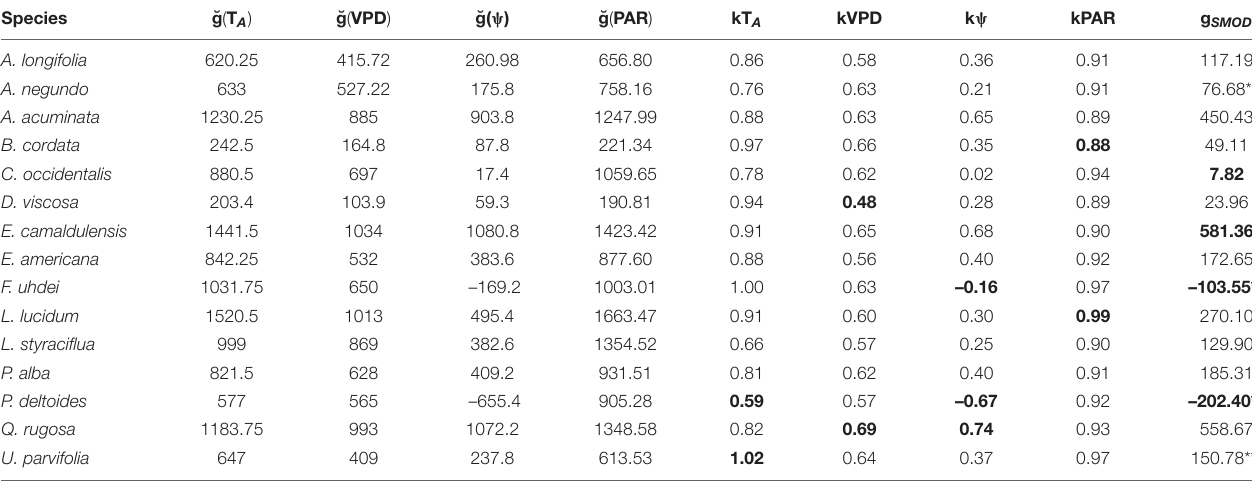
TABLE 6 | Predictions of stomatal conductance (g S ) using a multiplicative model (equation 5 from Methods, g SMOD ) and the contribution of each environmental ( kT A , kVPD , kPAR ) and physiological ( k ψ ) variable that can restrict or enhance stomatal performance in 15 tree species from Mexico City’s urban forest. Species ˘g ( T A ) ˘g ( VPD